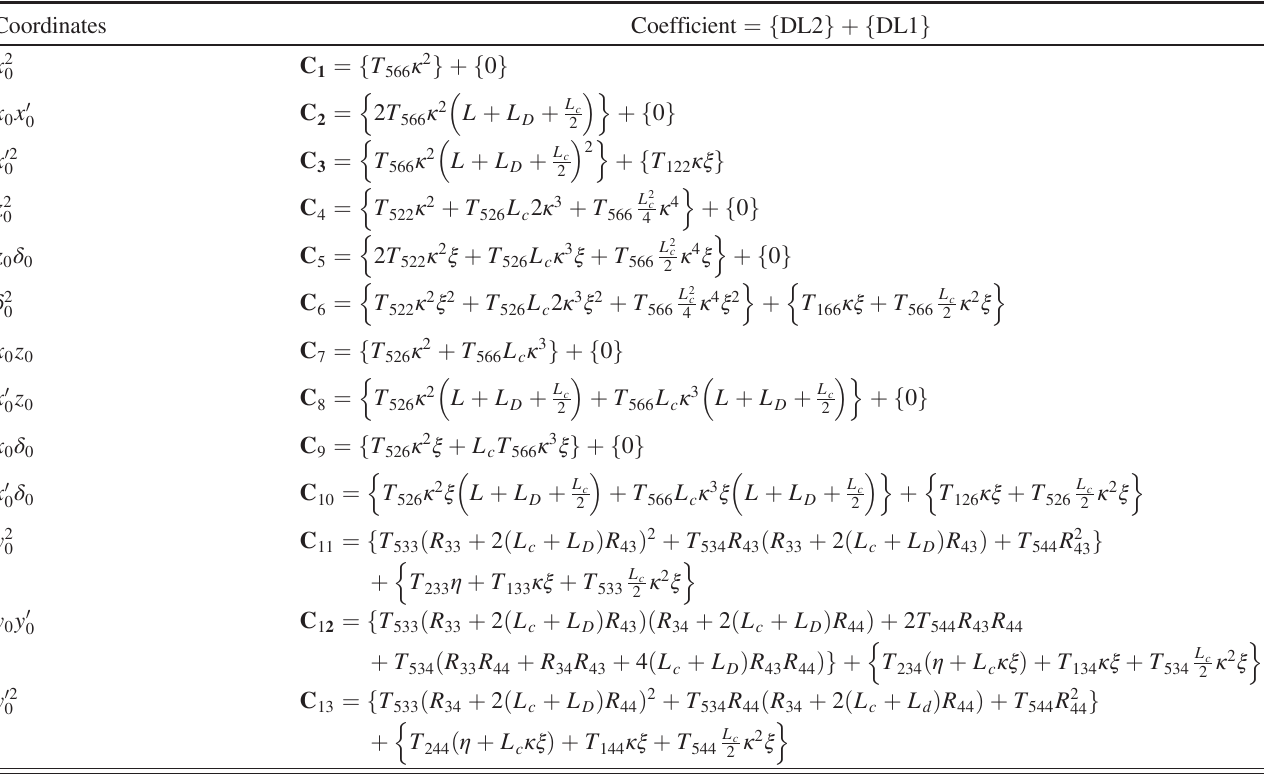
TABLE I. Second-order terms affecting the longitudinal bunch shape and its related particle coordinates. R and T are the first- and second-order matrix elements of the dogleg. These coefficients correspond to the EEX beam line in Fig. 1.